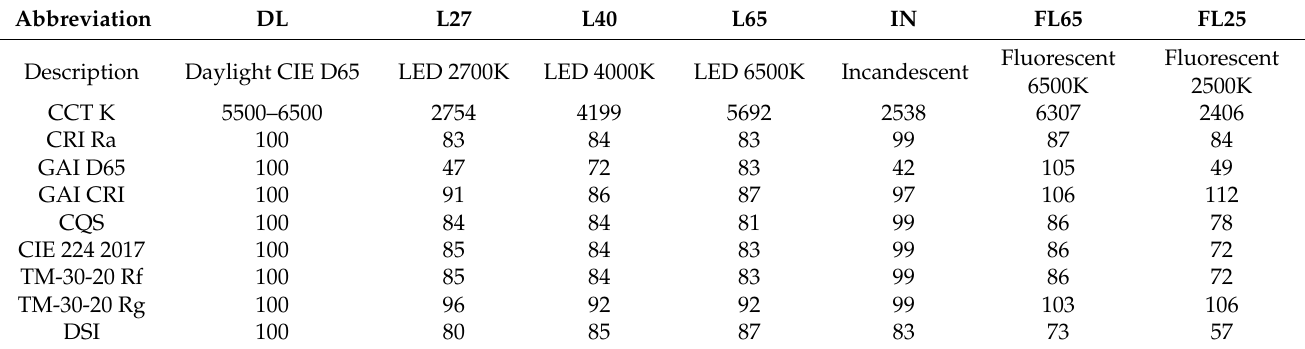
Table 2. Main colorimetric characteristics of the light sources studied in the testing